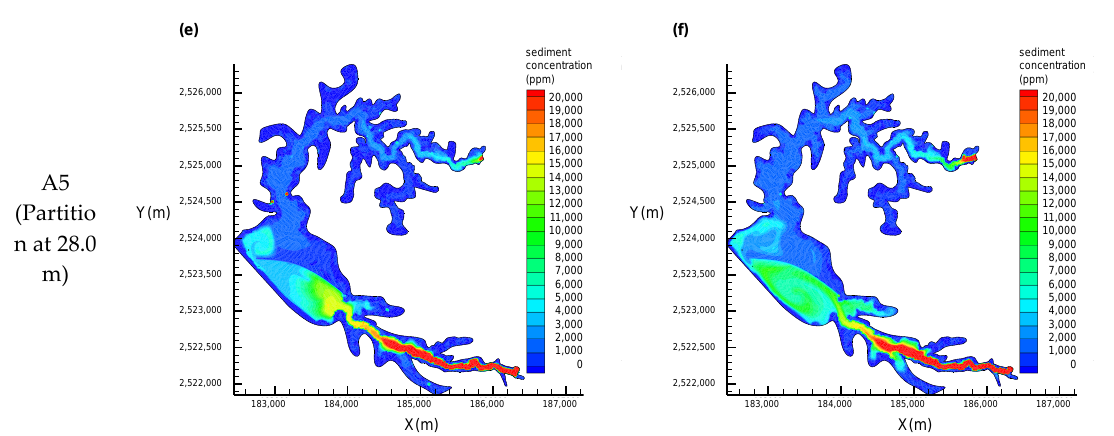
Figure 8. Example of the distribution of sediment concentration over time based on different drawdown strategies, including partition desilting, for Typhoon Fanapi of ( a ) drawdown strategy A1 after 3 hours; ( b ) drawdown strategy A1 after 12 hours; ( c ) drawdown strategy A2 after 3 hours; ( d ) drawdown strategy A2 after 12 hours; ( e ) drawdown strategy A5 after 3 hours; ( f ) drawdown strategy A5 after 12 hours;